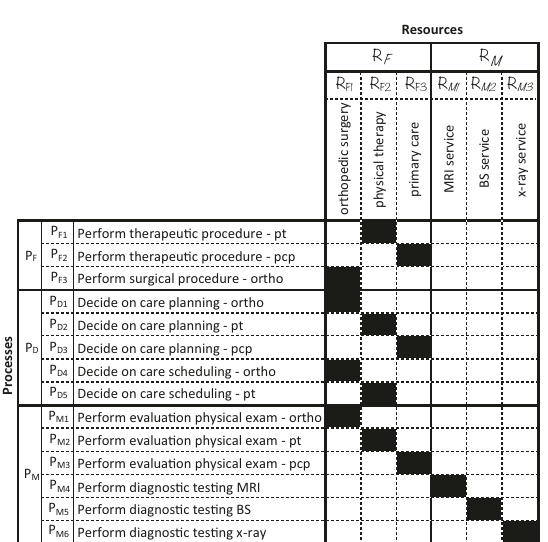
Figure 12: Higher level (transformation, decision, and measurement) knowledge base 𝐽 𝐹𝐷𝑀 with allocated aggregated processes to aggregated resources (dark filled), for the chronic diabetes example.